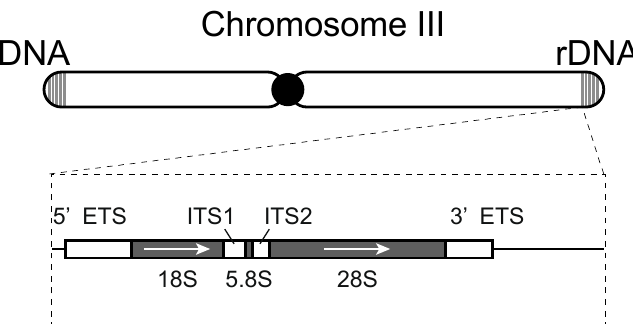
Figure 1. The structure of rDNA in S. pombe . rDNA regions exist on both ends of chromosome III in S. pombe . A single repeat of rDNA is shown in the dotted black box. 18S, 5.8S, and 28S rRNAs are transcribed by RNA polymerase I as the precursor rRNA from 5 ′ ETS (external transcribed spacer) to 3 ′ ETS. Four transcribed spacers (white boxes), including ITS (internal transcribed spacer) 1 and ITS 2, are removed by endonuclease and exonuclease processing.